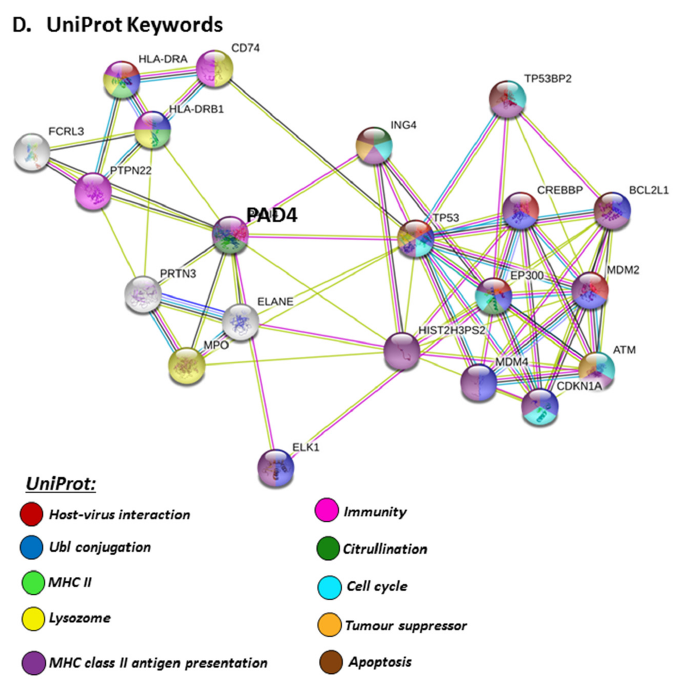
Int. J. Mol. Sci. 2019 , x , x FOR PEER REVIEW Figure 8. KEGG, GO and Reactome pathway analysis for PAD4, highlighting pathways relating to viral infections ( A ) Immune related GO biological pathways ( B ) Immune related Reactome pathways ( C ) and UniProt keywords ( D ) Colour code for the different pathways is shown within the figure. Individual coloured lines represent specific protein interactions that have been identified through interactions that are known (referring to experimentally determined connections and curated databases), through interactions that are predicted (referring to gene fusion, gene neighbourhood, gene co-occurrence) or through interactions identified via text mining, co-expression or protein homology (please refer to the colour key provided in the figure for the different connective lines) (PPI enrichment p -value: 1.21 × 10 − 5